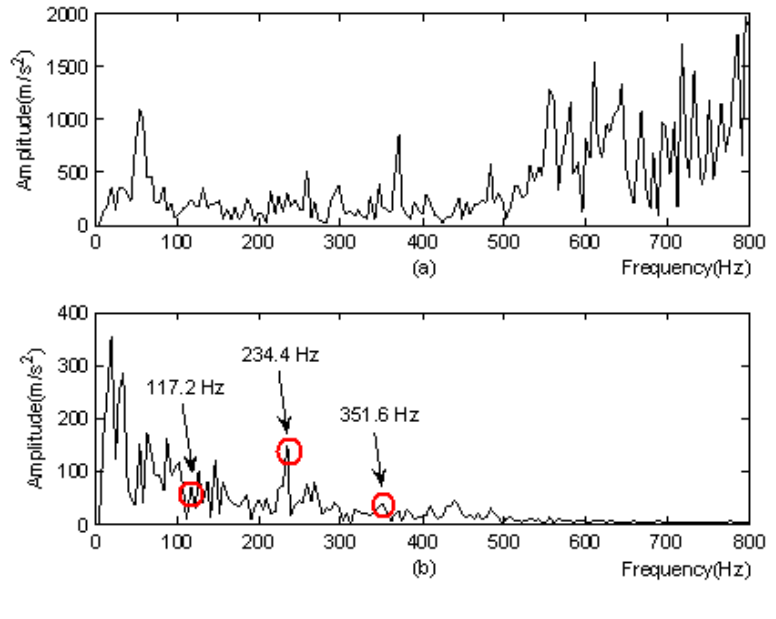
Figure 11. Modulation analysis: (a) local frequency spectrogram of signals. (b) modulation spectrogram after single-branch reconstruction of nodes.